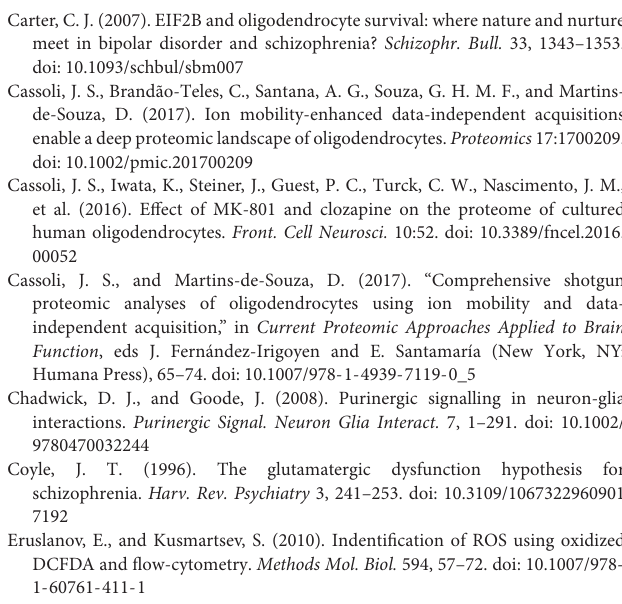
TABLE S4 | Proteins affected by quetiapine treatment. TABLE S5 | Proteins affected by risperidone